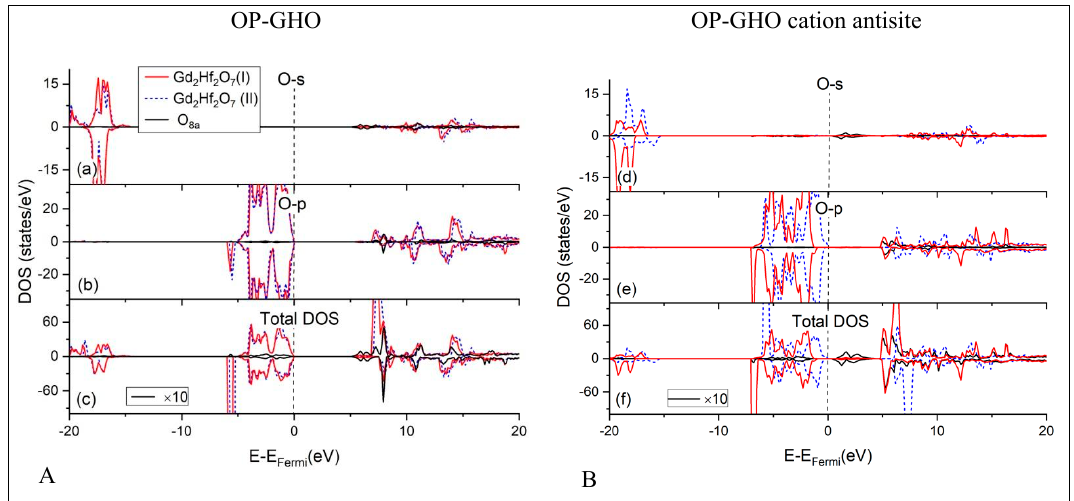
Figure 6. Gd DOS spectra per s, p, d, and f atomic orbitals for the OP-GHO structures, with the Ο 8a sites simulated via ghost atoms (I) and being vacant (II). ( A ). ( a ) – ( c ) stable structures and ( B ). ( d ) – ( f ) cation antisites.